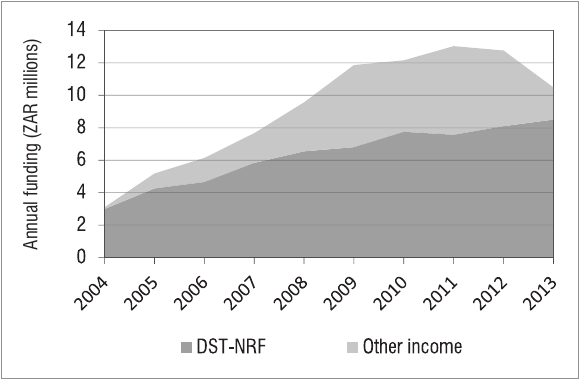
Funding to the Centre for Invasion Biology from the Depart- ment of Science and Technology (DST) through the National Research Foundation (NRF), and other sources, between 2004 and 2013. ‘Other income’ refers to contract funding which varies